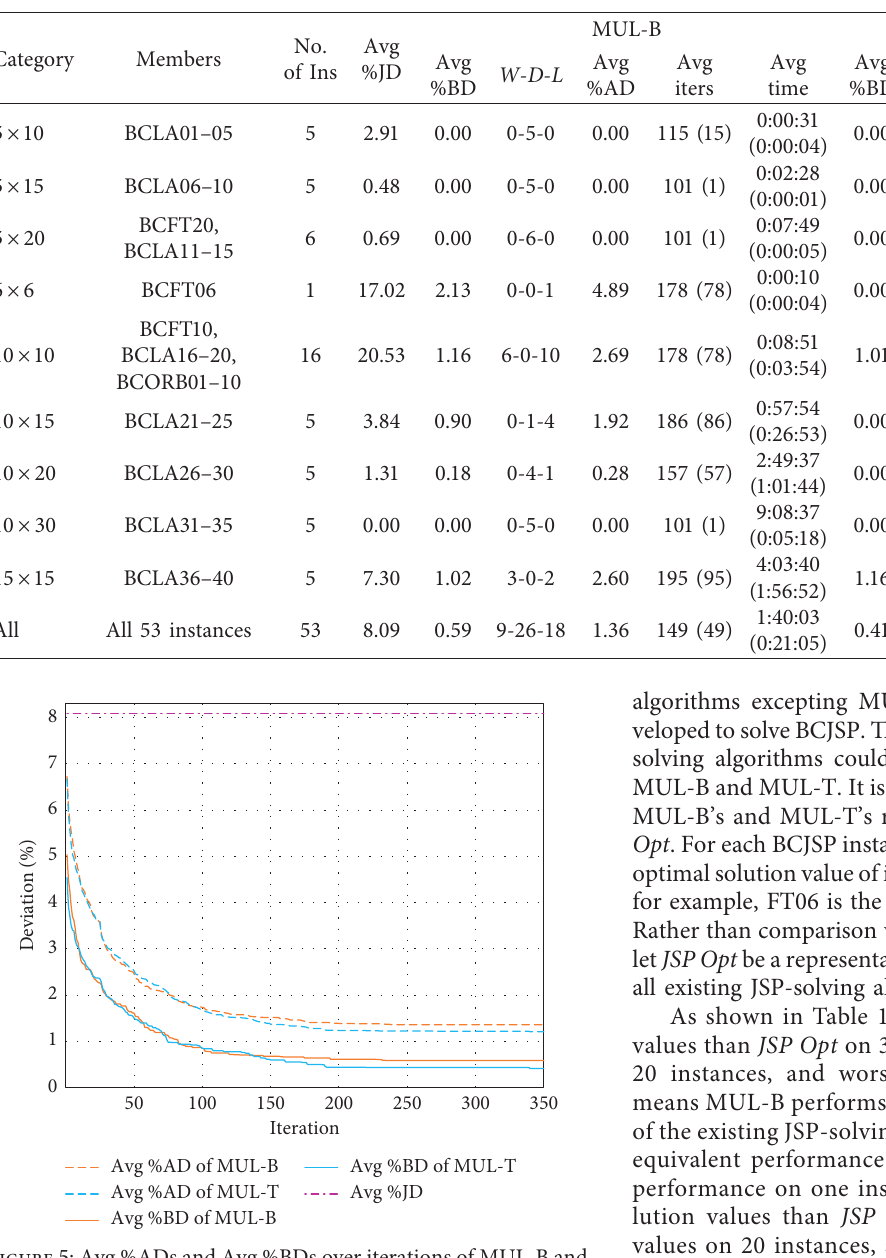
Table 2: A summary of experiment’s results.